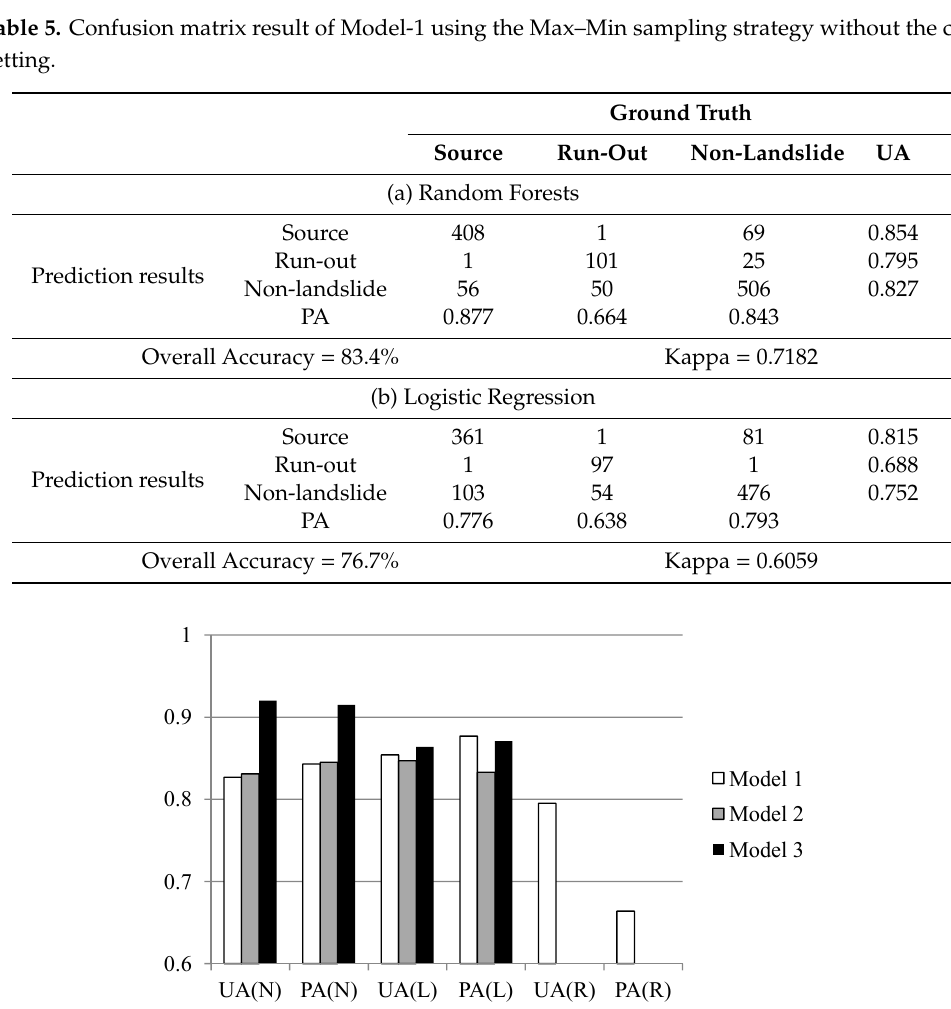
Figure 8. Quantitative evaluations of treating the run-out area as the landslide source (Model-2) and non-landslide (Model-3) classes compared with Model-1 using the Max–Min sampling strategy.